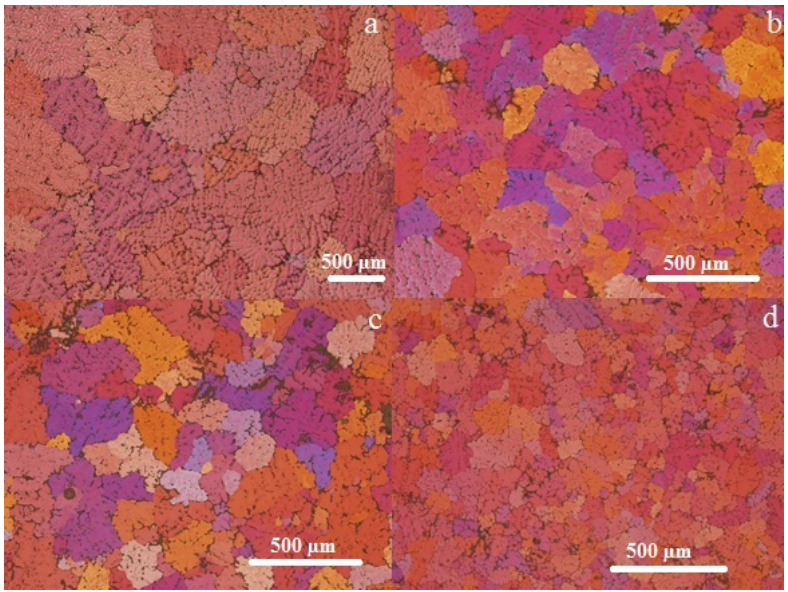
Figure 2. Optical images of the microstructure of the Al-5Mg ( a ), Al-5Mg-0.3W ( b ), Al-5Mg-0.5W ( c ), and Al-5Mg-0.8W ( d ) alloys.